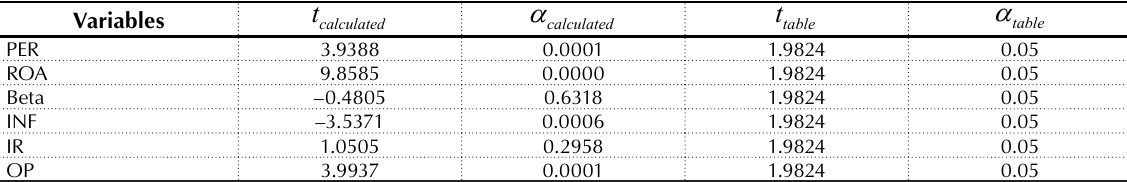
Table 4. t -test result (hypotheses